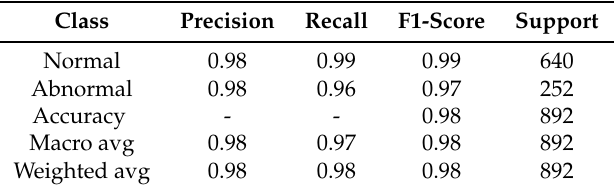
Table 7. Precision, Recall, and F1-Score metrics on the test set of the hybrid